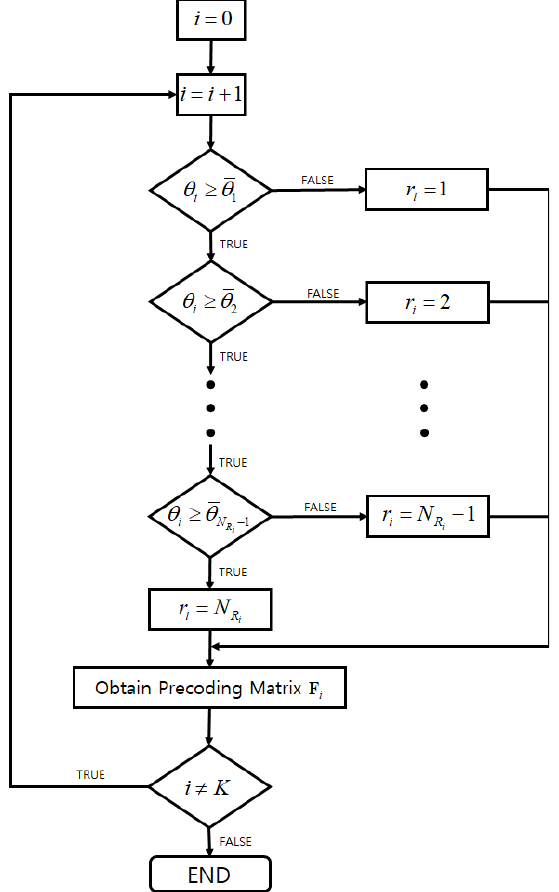
Figure 3. The algorithm of the adaptive modified generalized block diagonalization (MGBD)